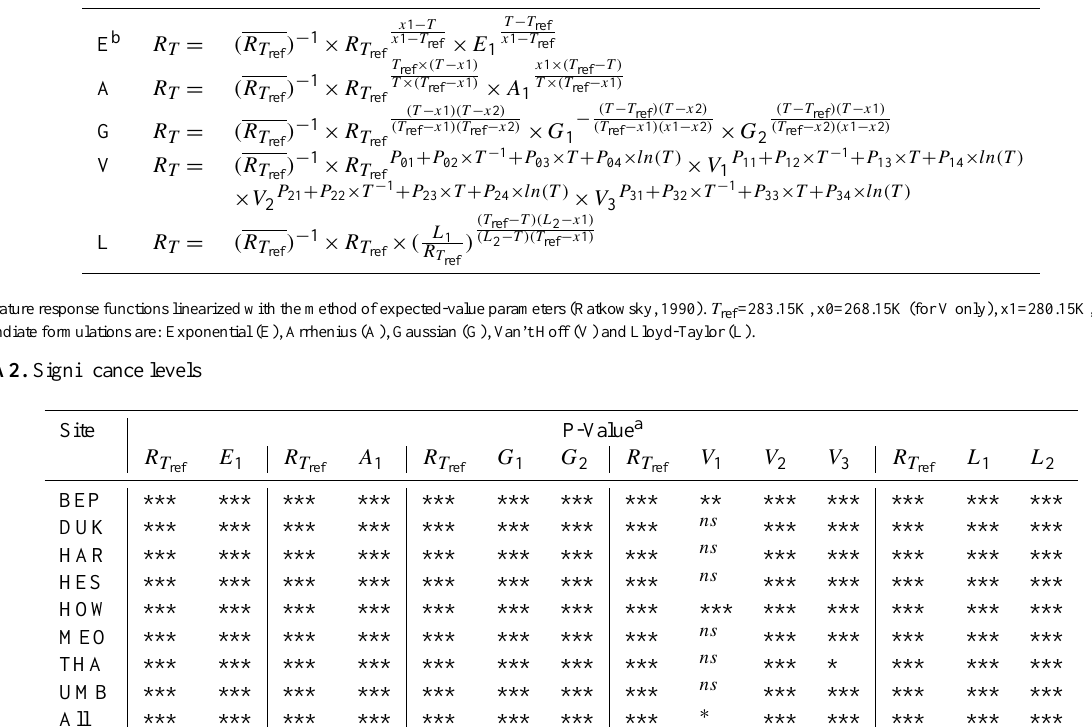
Table A1. Linearized temperature response functions Id